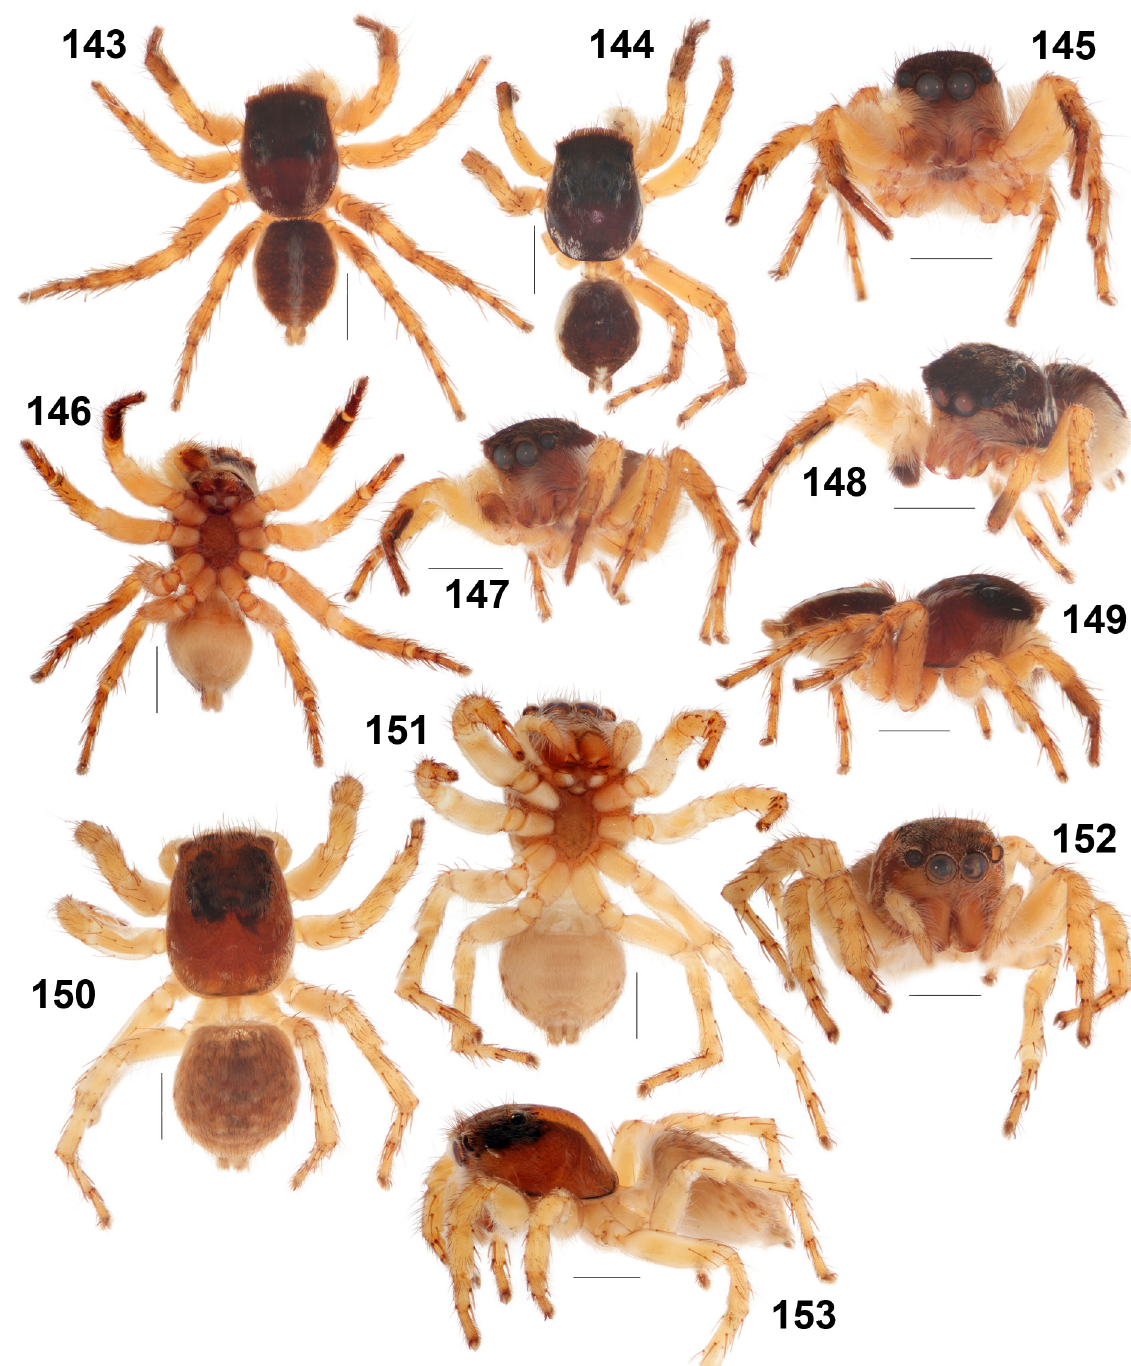
Figs 143–153. Manzuma nigritibia (Caporiacco, 1941) gen. et comb. nov., ♂♂ from Ethiopia (143, 145–147, 149, MRAC) and Yemen (144, 148, MRAC 212.800), holotype of Aelurillus reconditus , ♀ (150–153), general appearance. Scale bars: 1